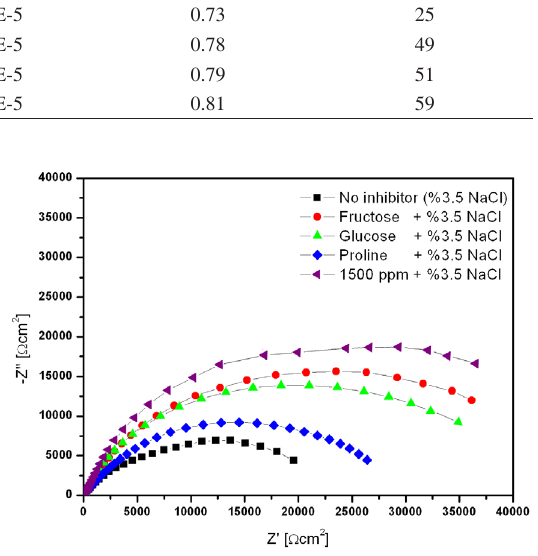
Figure 12. Nyquist plots of Al-2007 alloy in 3.5% NaCl media, 1500 ppm mad honey and the quantity of the studied compounds in 1500 ppm mad honey in 3.5% NaCl